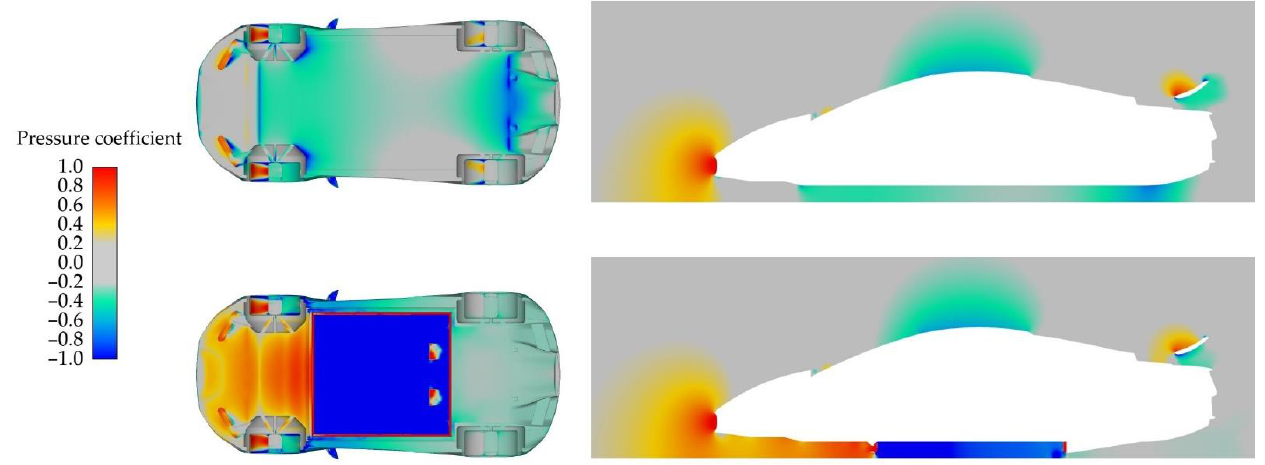
Figure 25. Pressure coefficient for inlet speed of 40 m/s, bottom, and symmetry views. ( Top ): without FDDG; ( bottom ): with the FDDG.